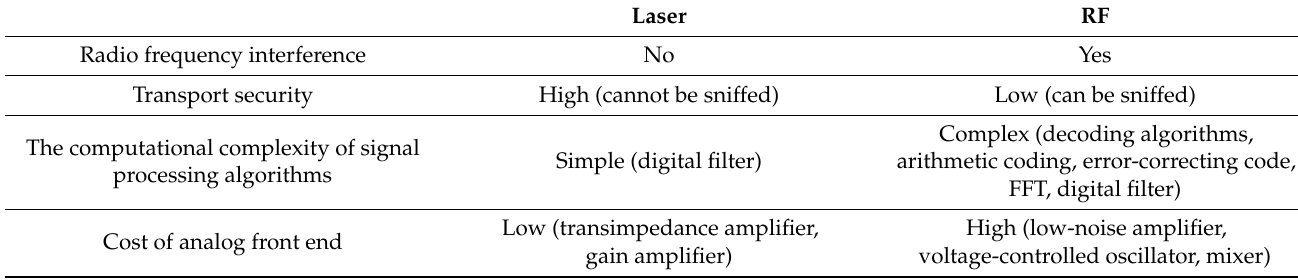
Table 1. The performance comparison of voice signal wireless transmission